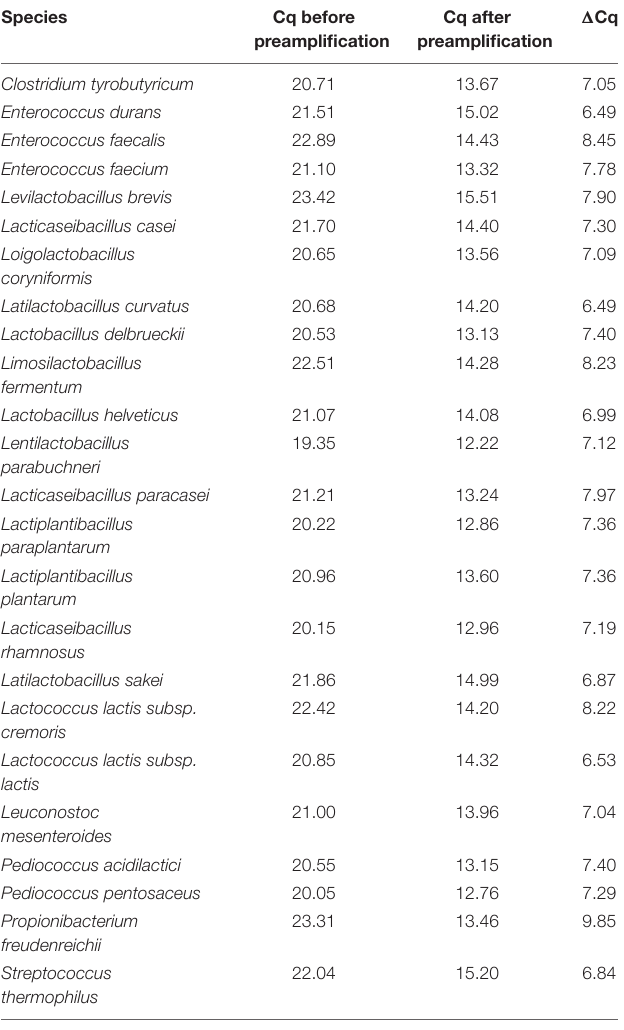
TABLE 3 | Quantification cycle values of a mock community sample with and without preamplification. Species Cq before Cq after preamplification